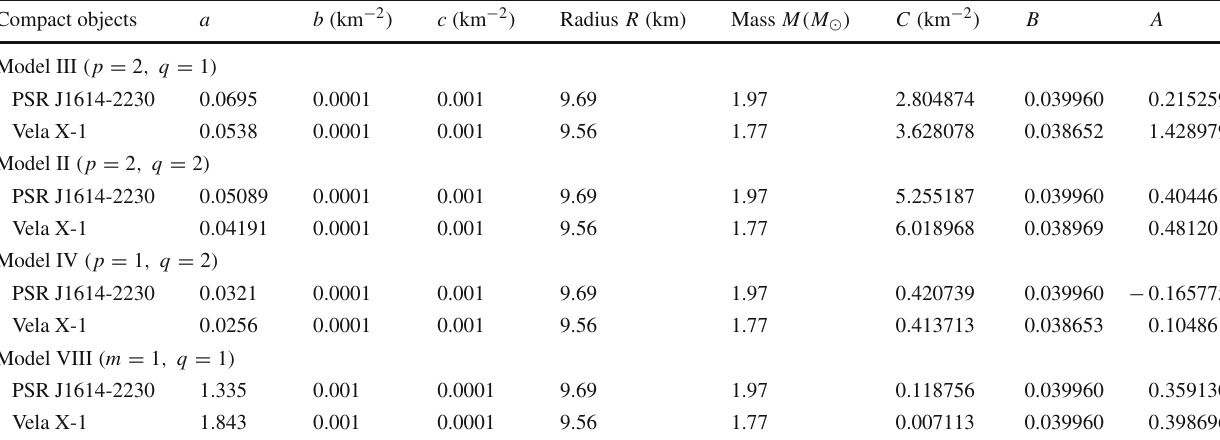
Table 2 Some values of the adjustable parameters a , b , and c that generate some compact objects having mass and radii similar to PSR J1614-2230 and Vela X-1. The observed mass and predicted radii of PSR J1614-2230 and Vela X-1 are taken from [82] Compact